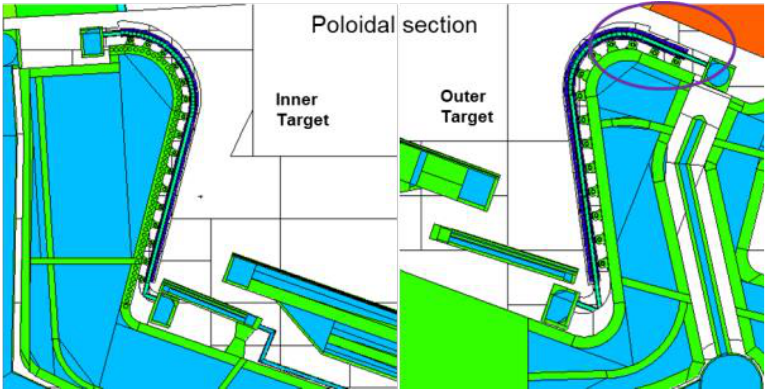
Figure 31. Poloidal profiles of the inner ( left ) and outer ( right ) target, highlighting the outer target, shielded by the bottom part of the outboard blanket portion of the outer target, shielded by the bottom part of the outboard blanket segment.